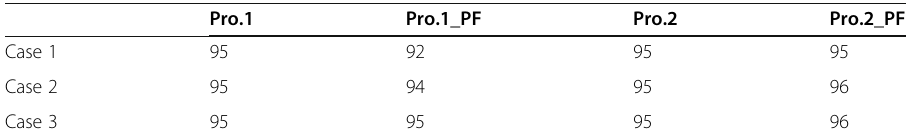
Table 7 PF values of proposed methods (%) Pro.1